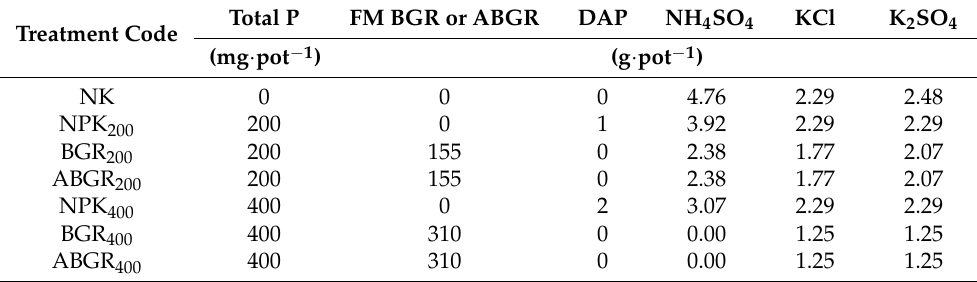
Table 1. Treatment codes and application rates of the applied fertilizers a